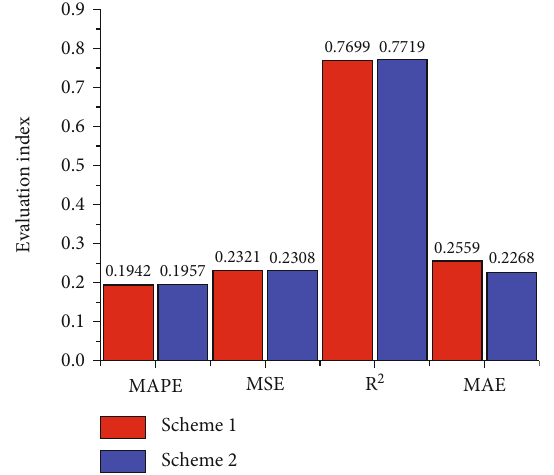
Figure 9: Results of di ff erent forecasting